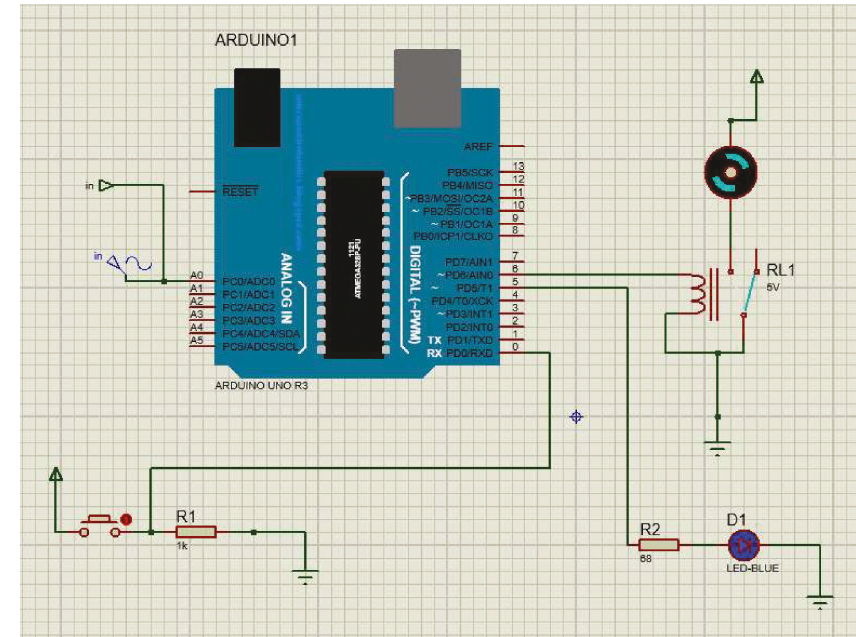
Figure 15: Control circuit.